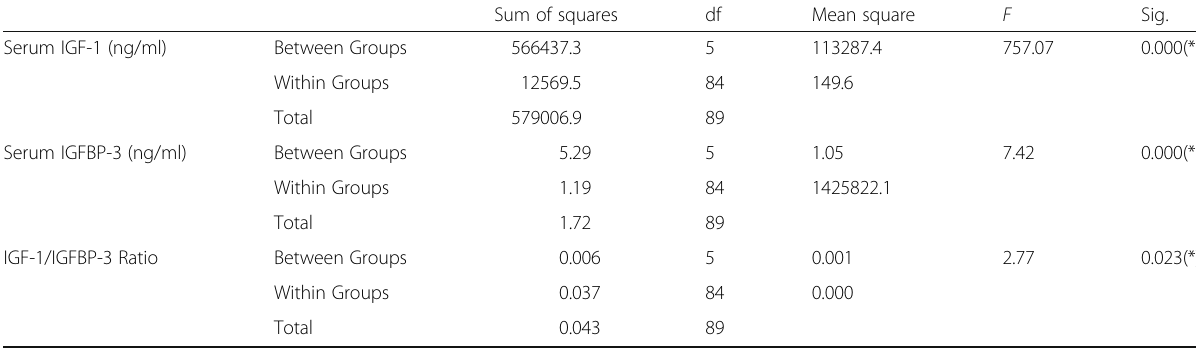
Table 2 1-way ANOVA showing IGF-1, IGFBP-3 and their ratio differences ’ between and within the CVMI stages Sum of squares df Mean square F Sig. Serum IGF-1 (ng/ml) Between Groups 566437.3 Within Groups Serum IGFBP-3 (ng/ml) Between Groups Within Groups Total IGF-1/IGFBP-3 Ratio Between Groups Within Groups Total